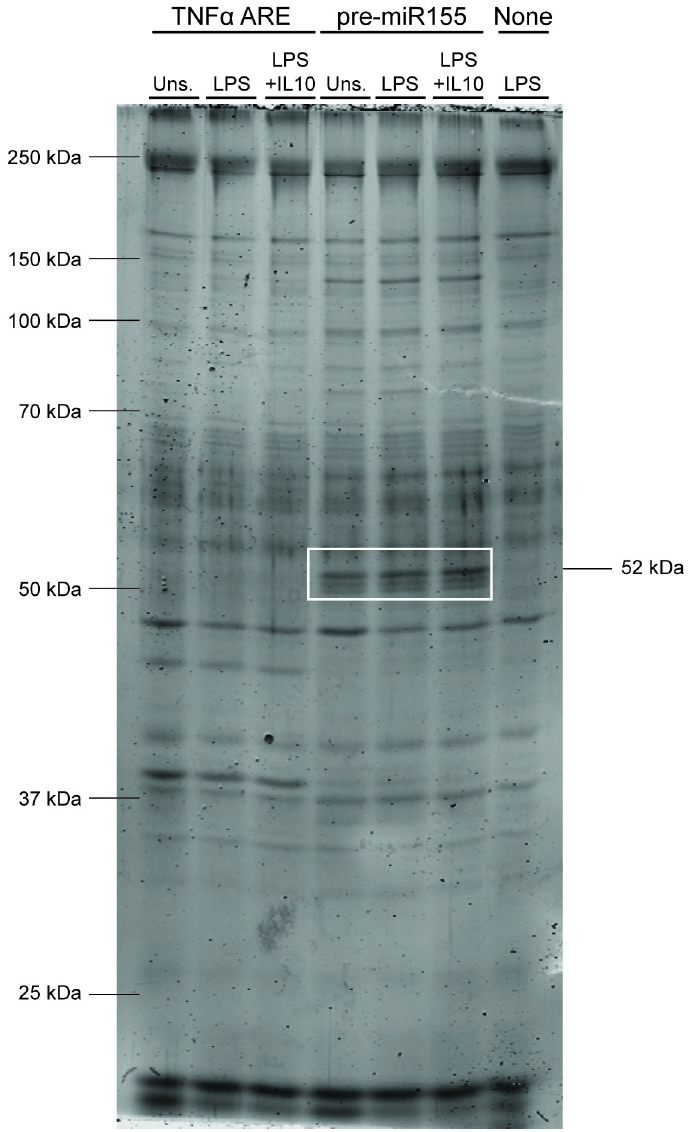
Fig 2. Identification of proteins interacting with pre-miR155 oligonucleotides. RAW264.7 cells were transfected with indicated biotinylated RNA-oligonucleotides and stimulated LPS +/- IL10 for 3 hours prior to collecting pulldown samples. The abundance of proteins interacting with pre-miR155 oligonucleotides were determined by blue- silver colloidal staining. The 52 kDa protein inside the white box is the protein speculated to be CELF2.